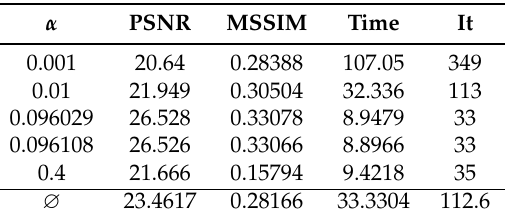
Table 3. Reconstruction of the cameraman-image corrupted by Gaussian white noise with σ = 0.1 for different regularization parameters α using the pdN with thresholded g .